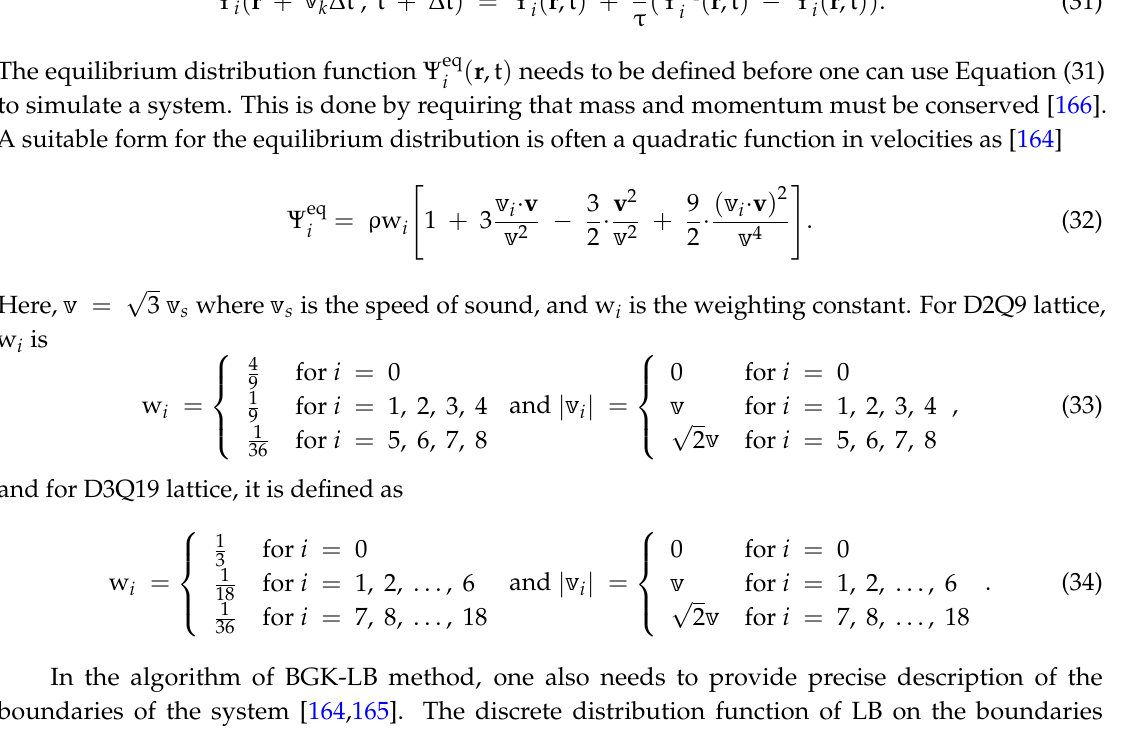
Figure 1. Two typical lattices often used in LB simulations: ( a ) D2Q9; and ( b ) D3Q19.